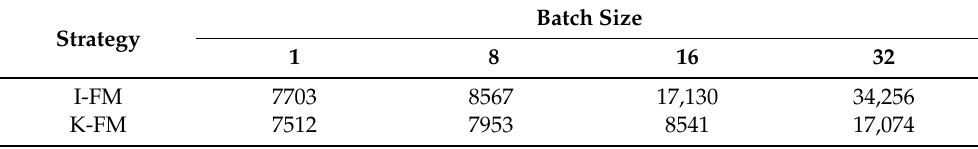
Table 4. Clock cycles under different